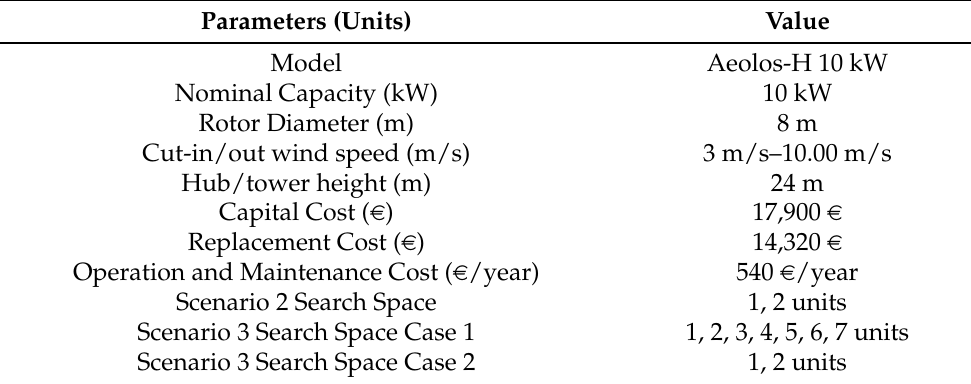
Table 6. Technical specifications and Costs of Aeolos-H 10 kW Wind